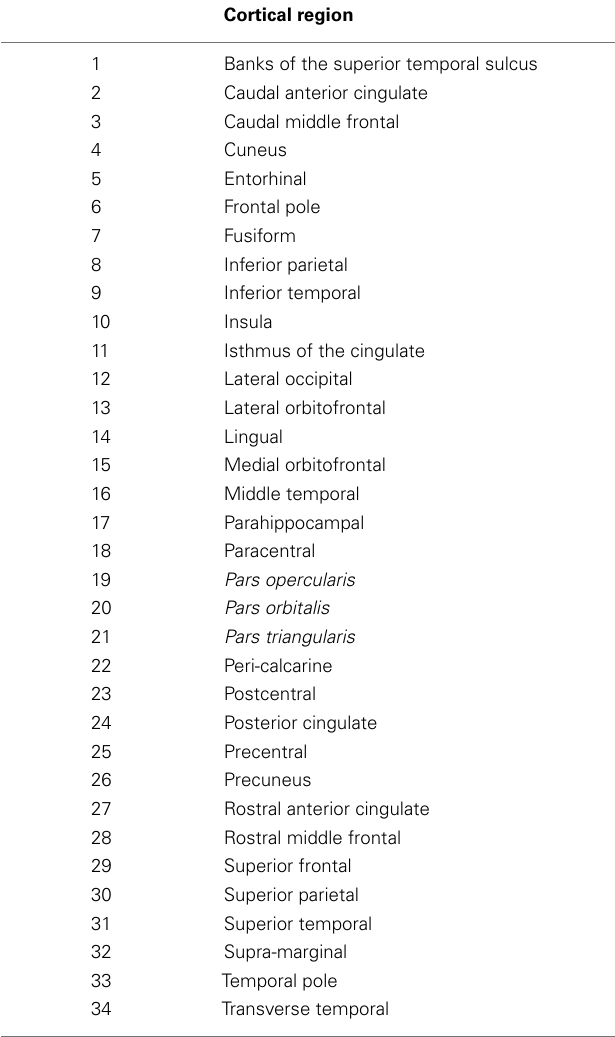
Table 1 | Complete list of cortical regions of interest (ROIs)